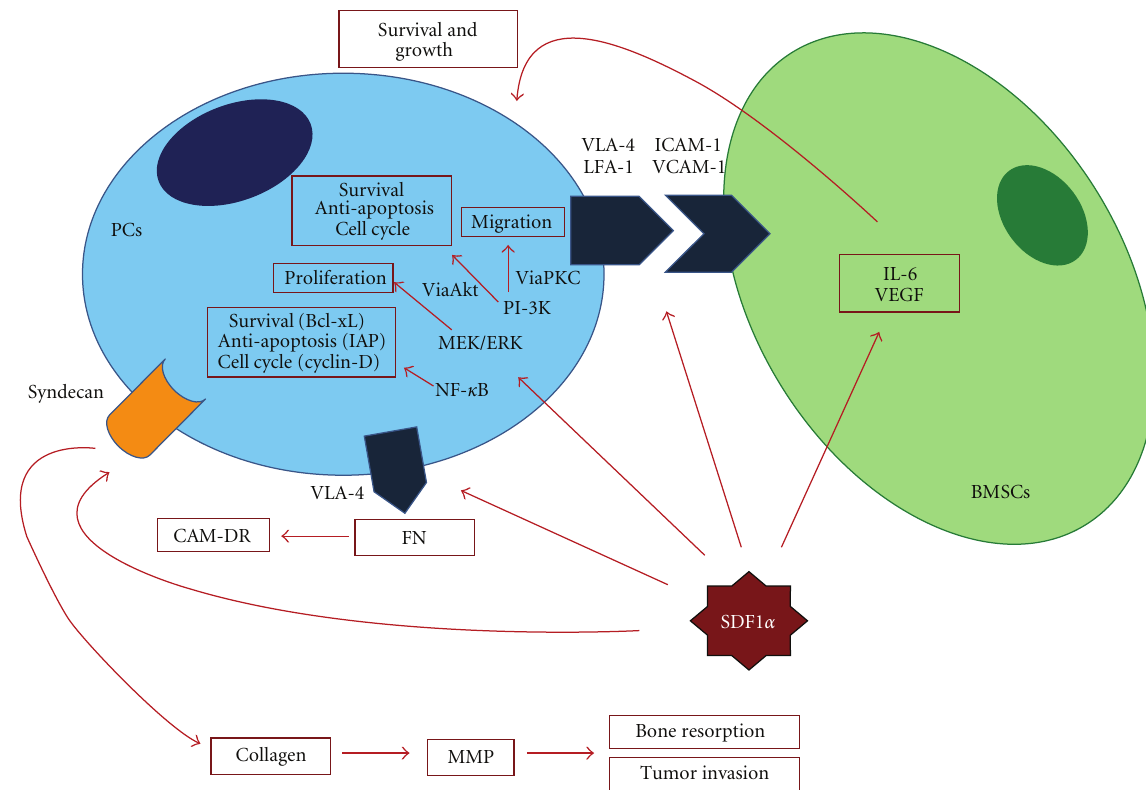
Figure 2: SDF-1 α actions and its functional sequelae.